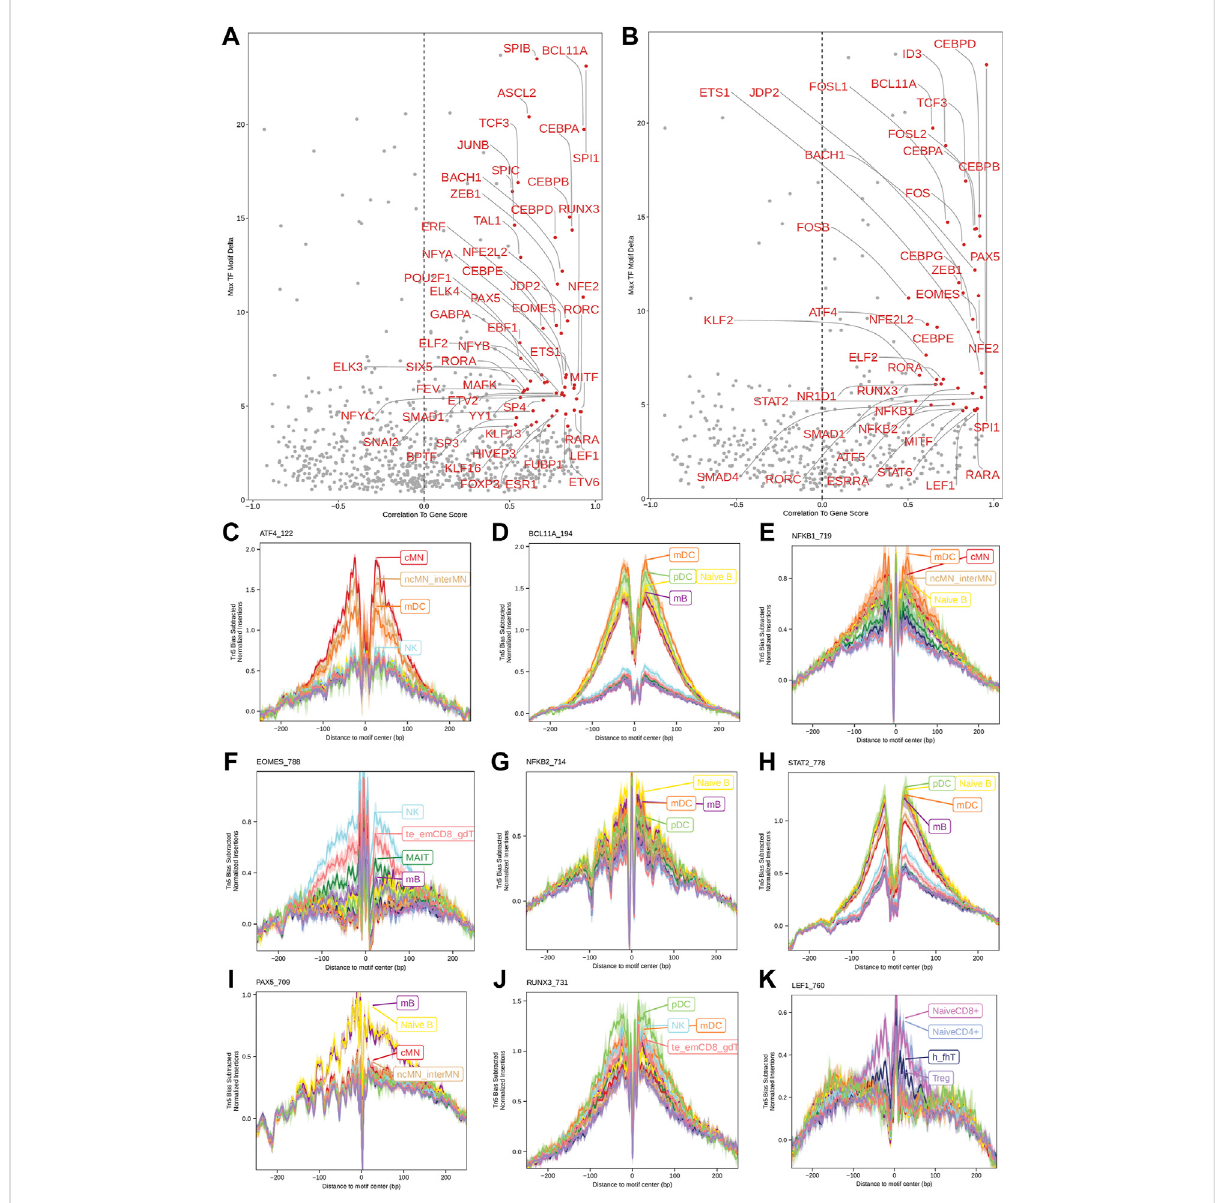
FIGURE 7 Identi fi cation of positive TF regulators in PBMCs based on gene scores or pseudo gene expression. (A,B) Positive TF regulators with red labels were identi fi ed by correlating gene scores and pseudo gene expression of TFs with deviation scores of their motifs across all human PBMCs, respectively. Seventeen positive TF regulators were identi fi ed by both methods. (C – K) Aggregate footprints of nine positive TF regulators preferentially functioning in different cell